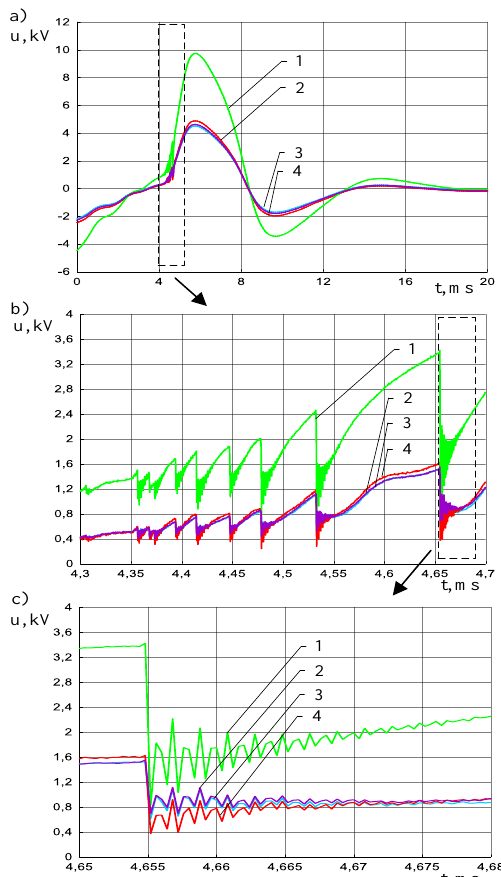
Figure 9. Overvoltage waveforms inside the L3 phase winding when switching off the transformer Tr, protected by surge arresters with a vacuum circuit breaker connected to the transformer with an 85 m long cable line (Figure 3): ( a ) full scale, ( b , c ) different zooms of figure a), 1 — phase voltage waveform on the winding line terminal (x/l = 1.0), 2 — voltage waveform in the middle of the winding (x/l = 0.5), 3 — waveform of the overvoltage in the point with the coordinate x/l = 0.53, 4 — waveform of the overvoltage in the point with the coordinate x/l = 0.47.